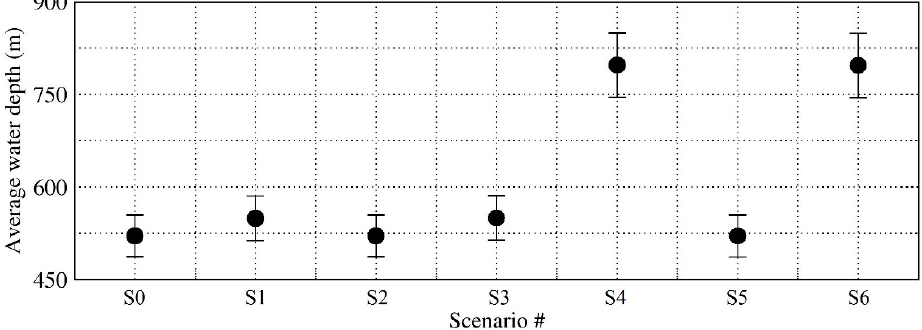
Figure 4. Average water depth at which the base of the GHSZ intersects the seafloor, considering the estimated error.